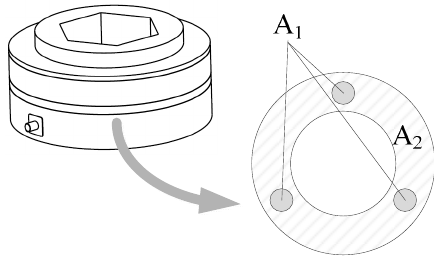
Figure 7. The force-bearing cross section of the sensor.